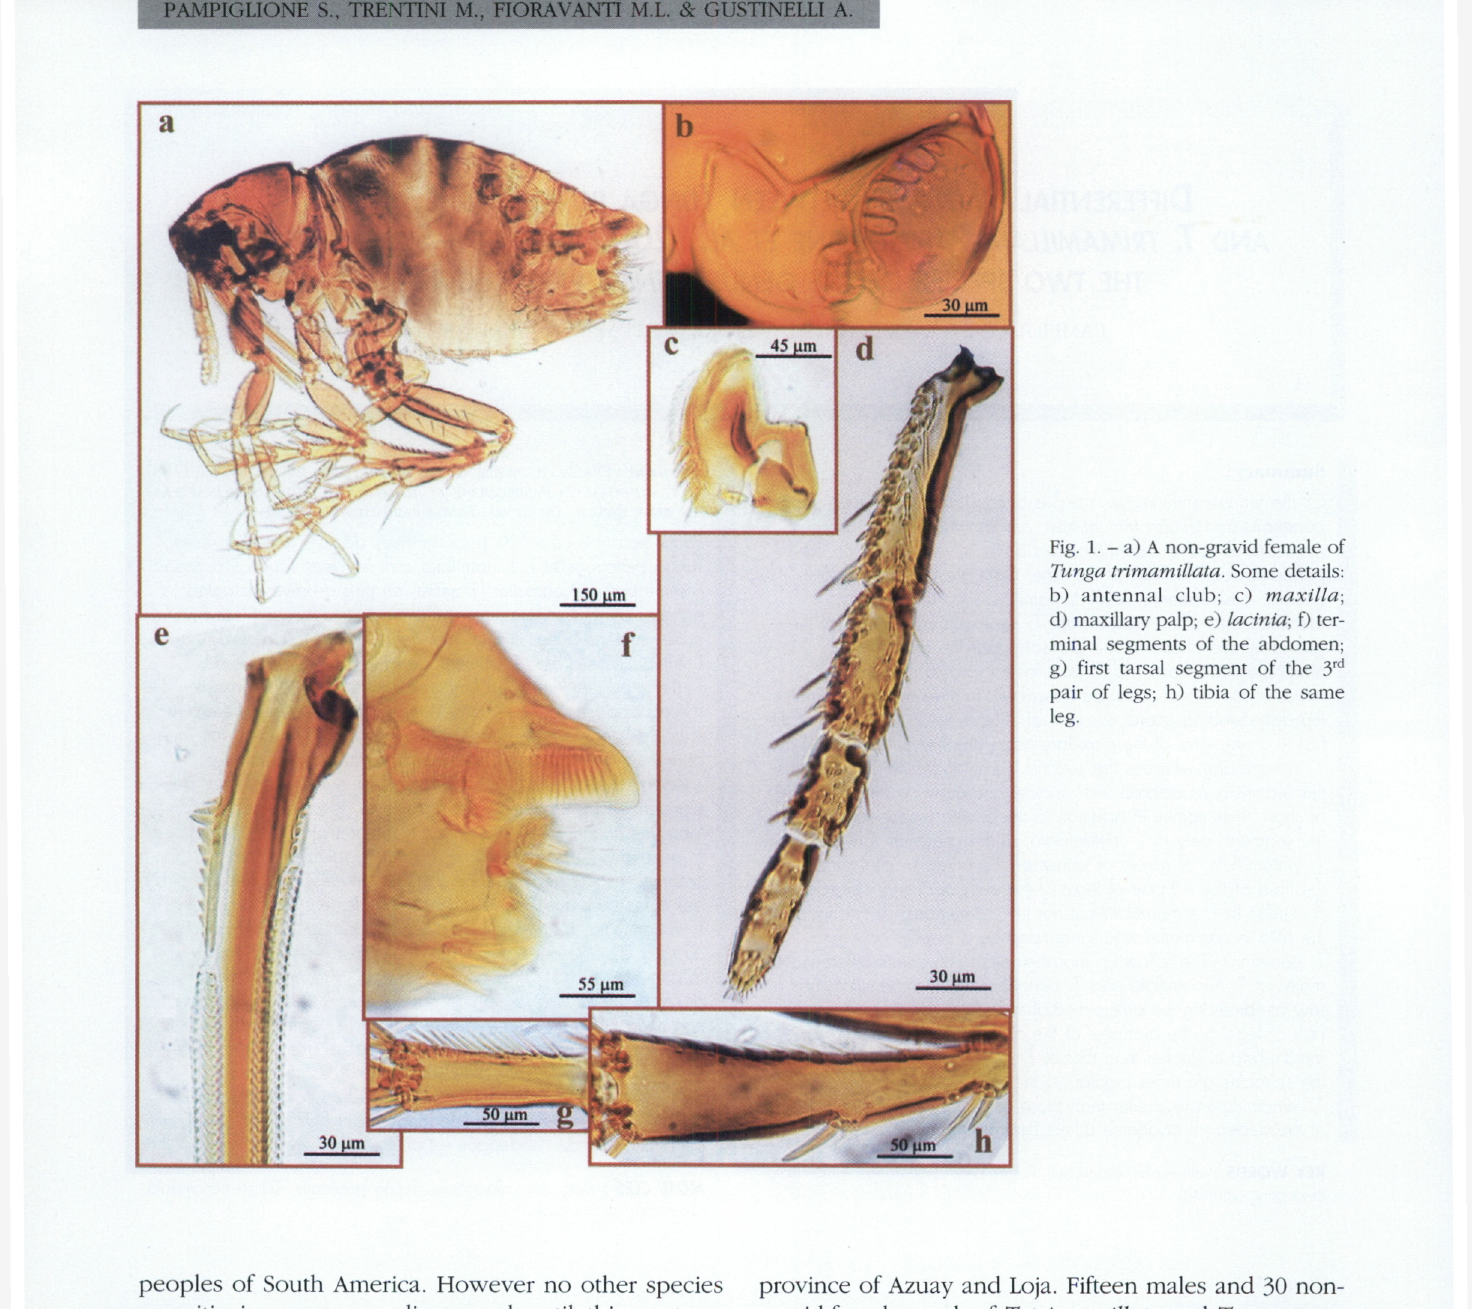
Fig. 1. - a) A non-gravid female of Tunga trimamillata. Some details: b) antennal club; c) m axilla ; d) maxillary palp; e) lacinia ; 0 ter­ minal segments of the abdomen; g) first tarsal segment of the 3rd pair of legs; h) tibia of the same